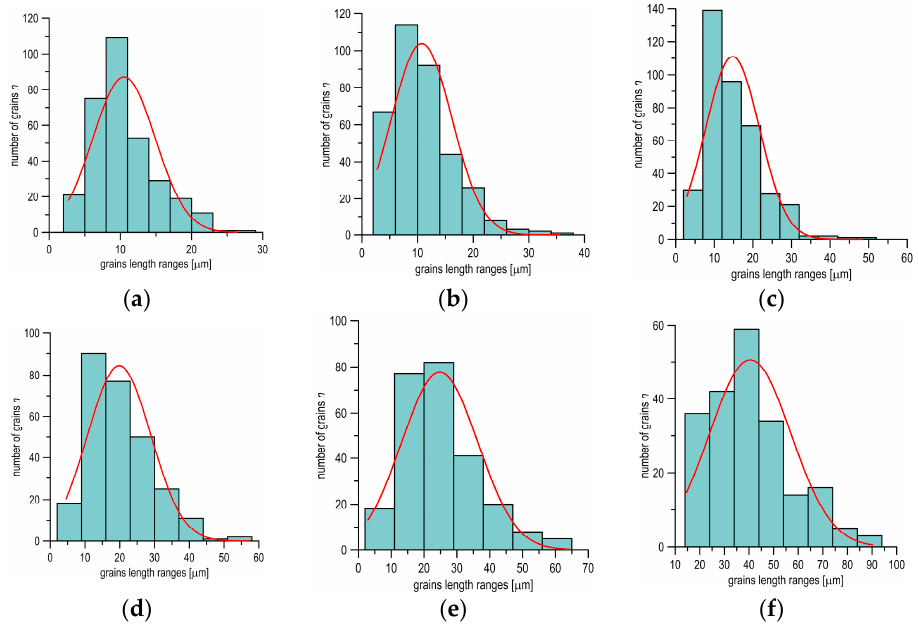
Figure 4. Histograms and graphs for normal distributions of grain length at different distances from the fracture plane of the specimen: ( a ) 17 mm; ( b ) 10 mm; ( c ) 5 mm; ( d ) 3 mm; ( e ) 2 mm; and ( f ) 0.1